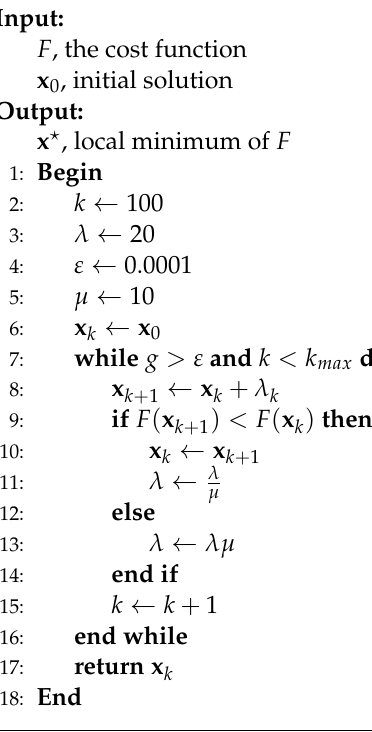
Algorithm 1 Iterative procedure solving Equations (1):